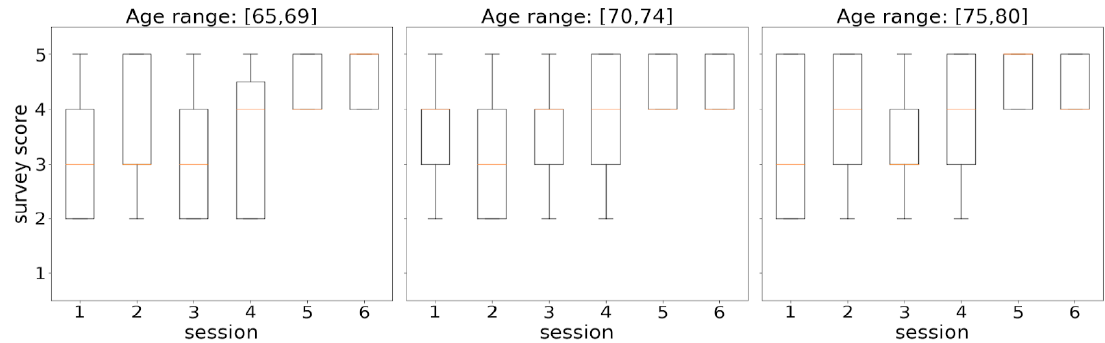
Figure 17. Distributions of survey responses by session from an age perspective. Sensors 2021 , 20 , x FOR PEER REVIEW